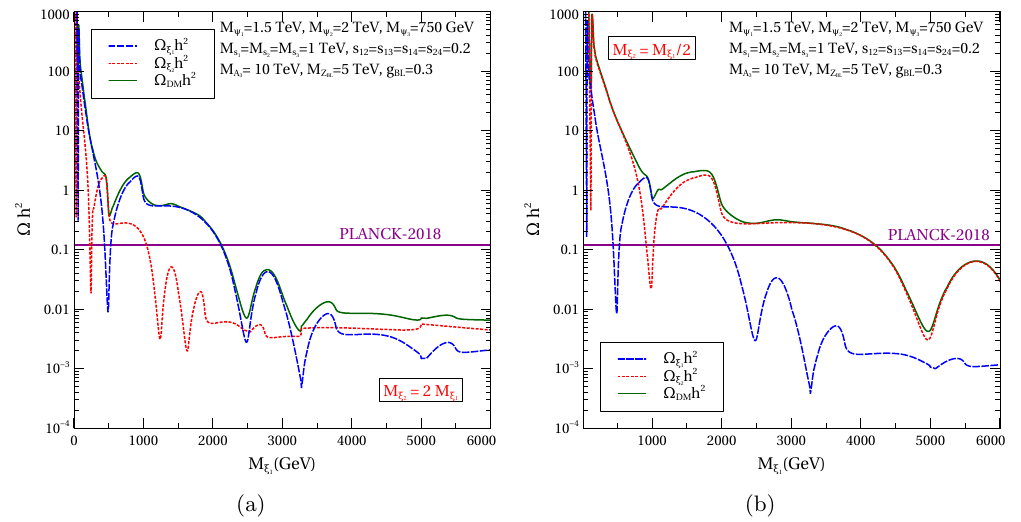
Figure 5 . Relic abundance of two DM candidates with non-degenerate masses: M (cid:24) panel) and M (cid:24) = M (cid:24) = 2 (right panel), keeping all other model parameters (cid:12)xed to benchmark val- 2 1 ues.